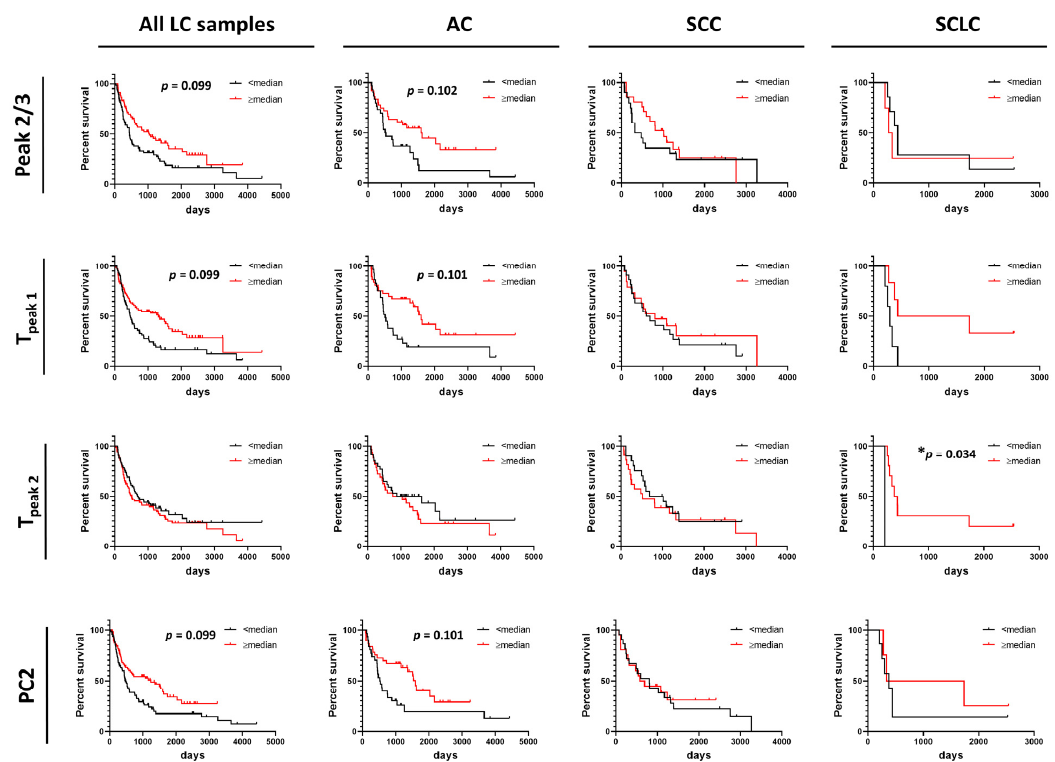
Figure 5. Association between overall survival of lung cancer patients and summary metrics or PCs. Analysis of survival functions for overall survival of lung cancer patients dichotomized by median values of selected summary metrics/PCs, using the Mantel–Cox test. Graphs in the first column represent data for all combined lung cancer patients ( n = 133), columns two to four represent patients dichotomized by LC subtypes: AC LC ( n = 66), SCC LC ( n = 41) and SCLC ( n = 11), respectively. *, adjusted p -value < 0.05.